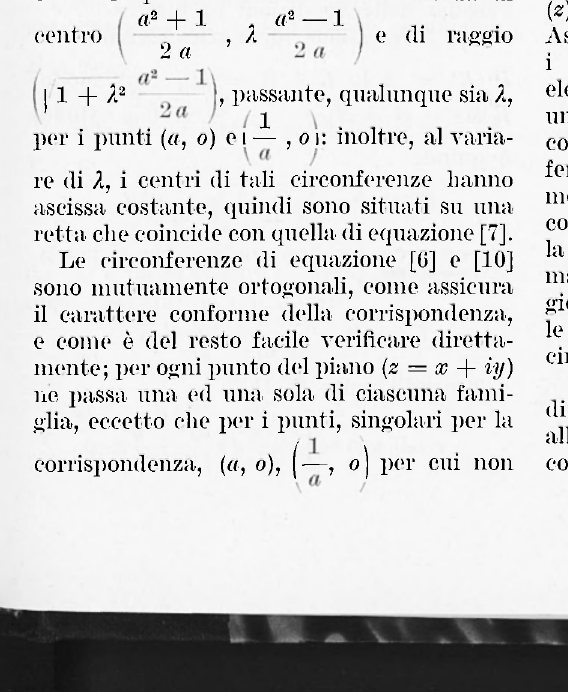
La fig. 2 mostra l'andamento dei sistemi di circonferenze [t3] e [10].